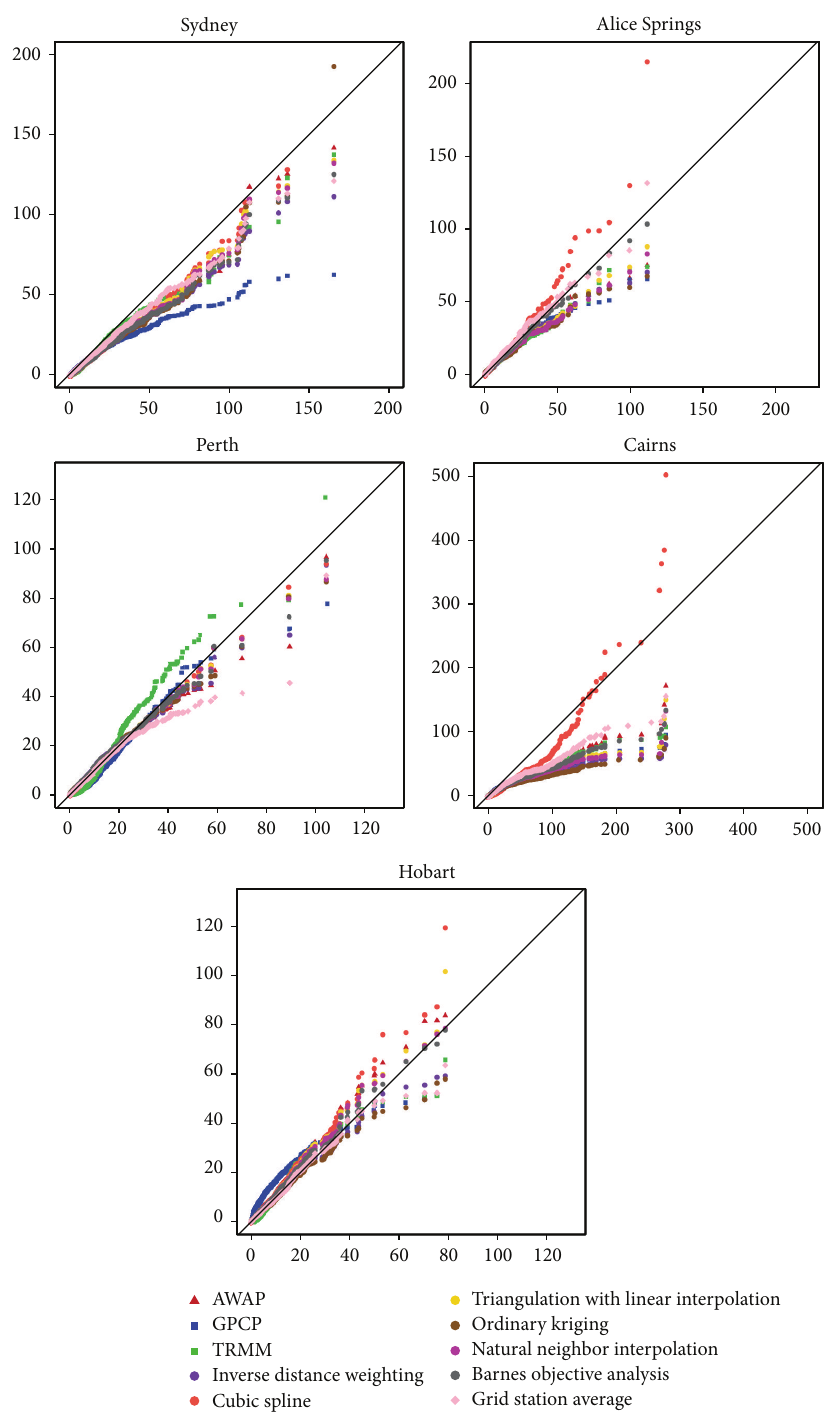
Figure 6: Plots of quantiles of the in situ gauge observations at five different locations: Sydney, Alice Springs, Perth, Cairns, and Hobart, against the quantiles of all ten gridded datasets in this study, including AWAP, TRMM, and GPCP, and the seven new gridded datasets. The symbols vary based on the type of dataset: triangle for AWAP, square for the merged datasets TRMM and GPCP, circle for the interpolated datasets, and a diamond for the grid average. The stations were chosen to represent the varying climatic regions across Australia. For each QQ pair, 𝑁 quantiles are plotted, where 𝑁 equals the number of nonmissing values in the dataset with the most missing values. All numbers have units of